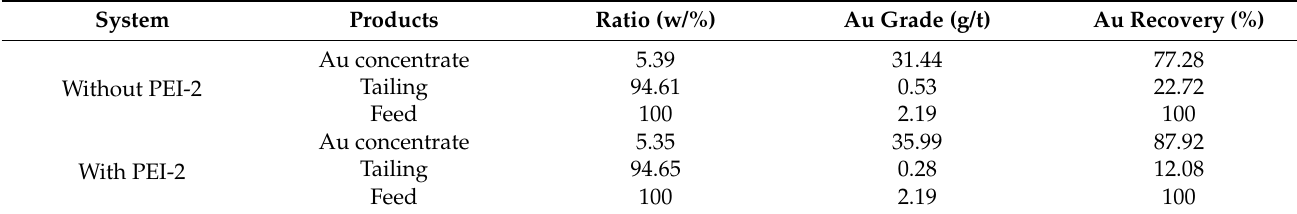
Table 1. Values of closed flotation